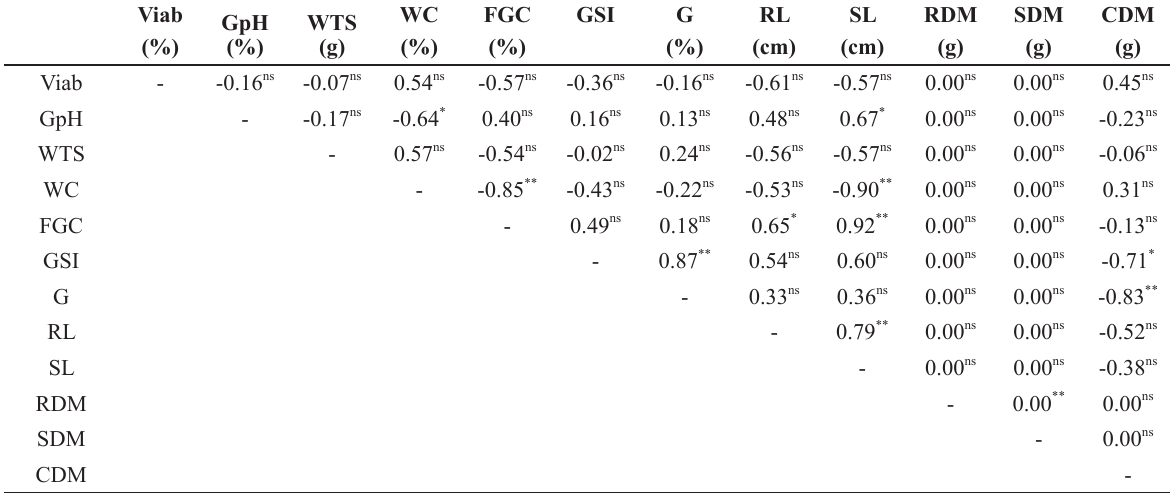
Pearson’s simple correlation coefficients (r) estimated between water content (WC), weight of one thousand seeds (WTS), first germination count (FGC), germination speed index (GSI), germination (G), root length (RL), shoot length (SL), root dry mass (RDM), shoot dry mass (SDM), cotyledons dry matter (CDM) of seedlings and percentage of viability (Viab)